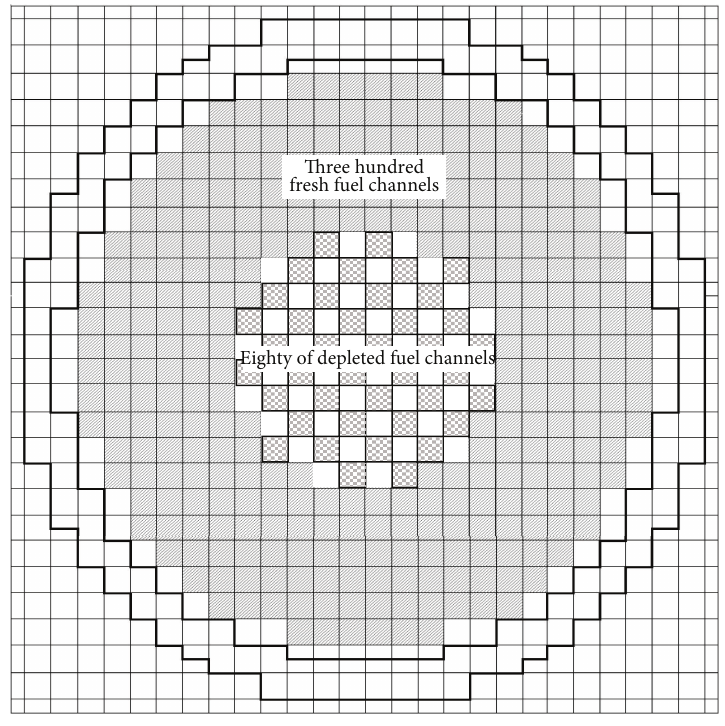
Figure 2: Position of the depleted fuel channels.